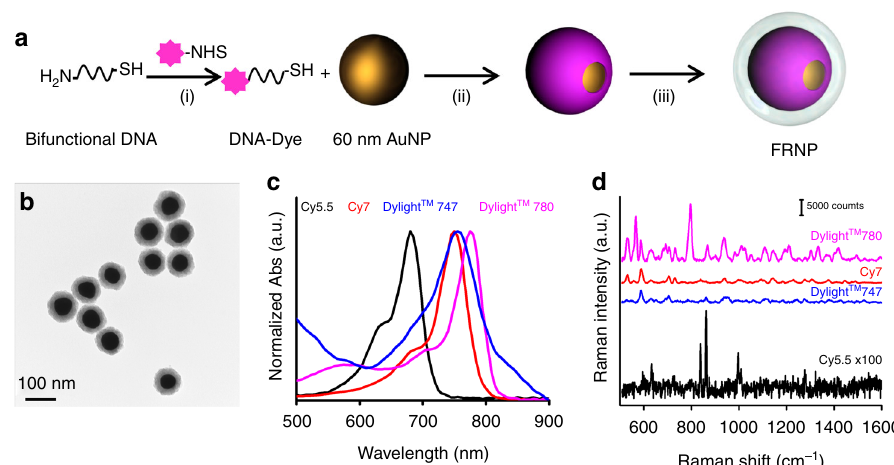
Fig. 2 Raman reporter selection. a Fabrication of FRNPs. (i) A bifunctional amine-thiol modi fi ed DNA is labeled with a NIR fl uorophore via straightforward NHS ester chemistry. (ii) Thiol-ends of the fl uorophore-labeled DNAs are grafted on to the AuNP surface to create a fl uorophore shell. (iii) NPs are silicated using a modi fi ed Stöber method. b Representative TEM image of the FRNPs. c The UV – vis absorption spectra of the 4 different fl uorophores selected. d The representative baseline-subtracted Raman spectra of 100 fM of the FRNPs synthesized using the 4 fl